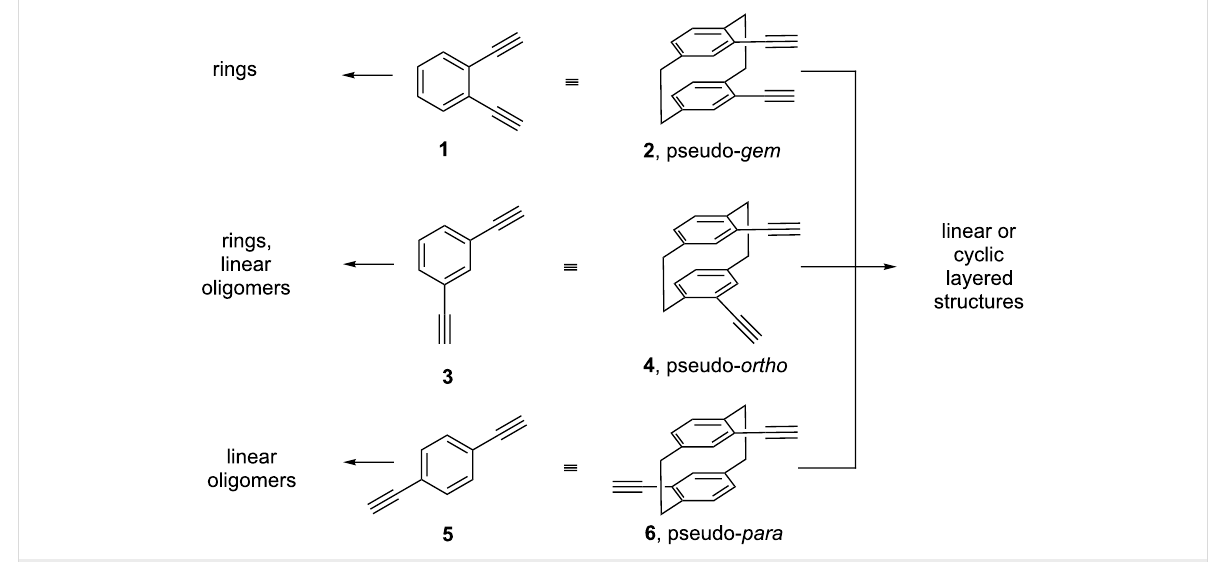
Scheme 1: Planar and layered ethynyl aromatics as building blocks for extended aromatic